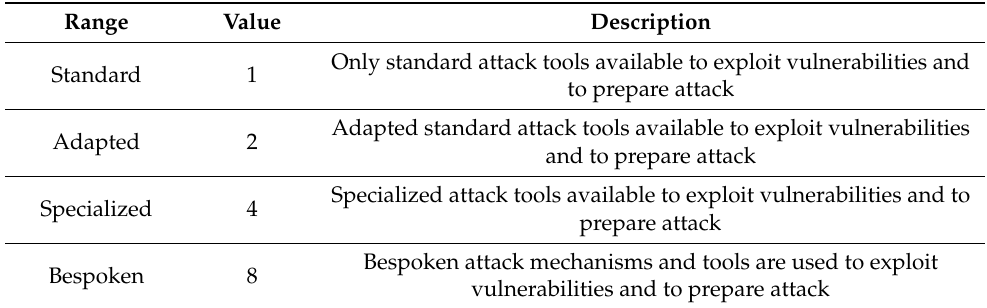
Table 11. Attack potential factors: